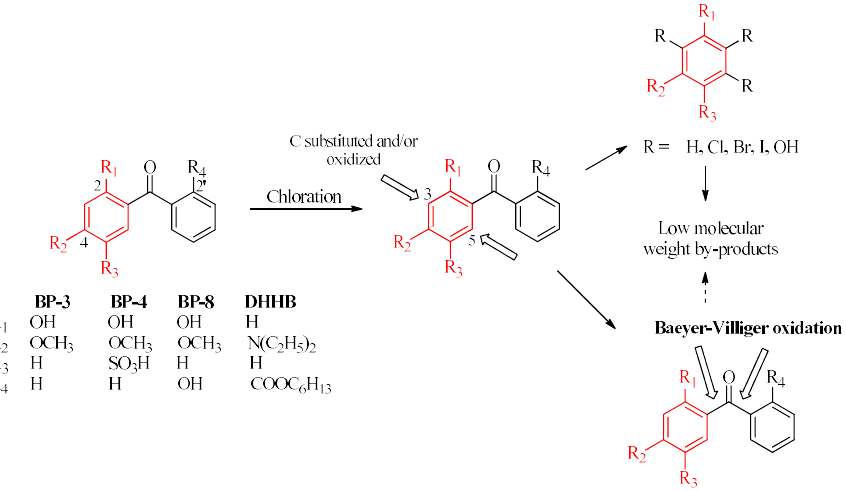
Scheme 1. Chemical filters derived from benzophenones and possible reactive